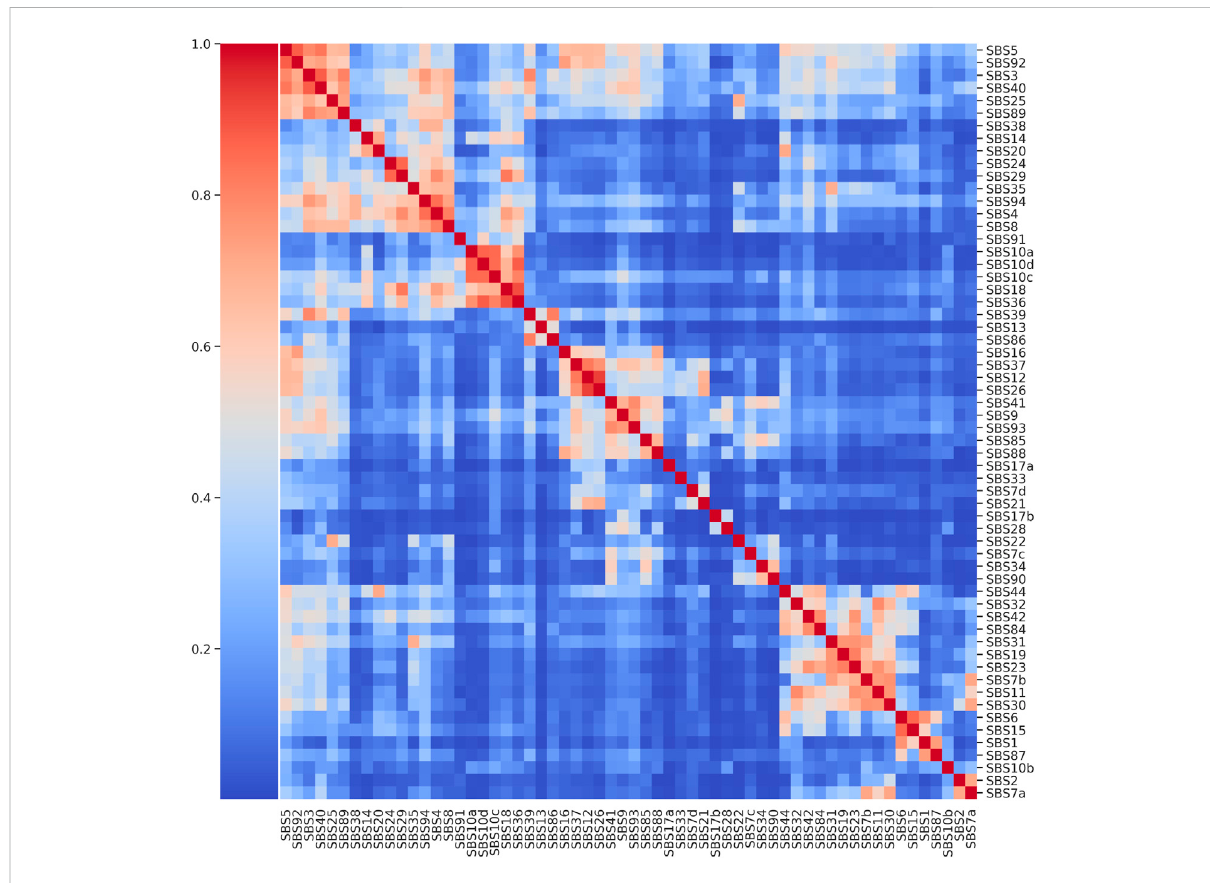
FIGURE 2 Cluster map of COSMIC SBS Mutational Signatures. Pairwise cosine similarity displayed for the 60 SBS signatures from COSMIC